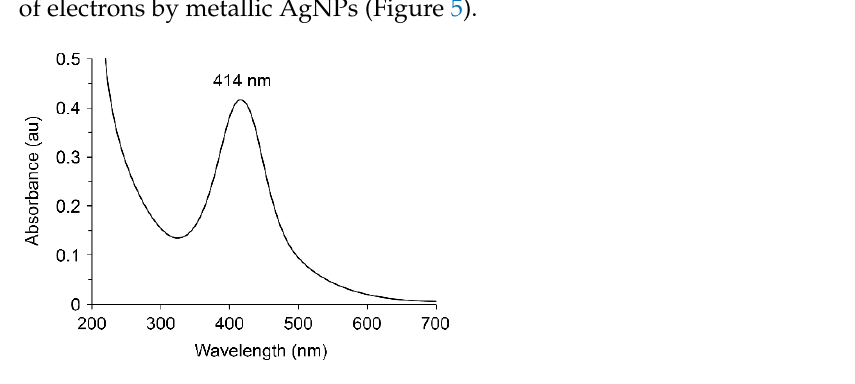
Figure 5. UV – Vis spectra for nanocomposite with AgNPs stabilized by